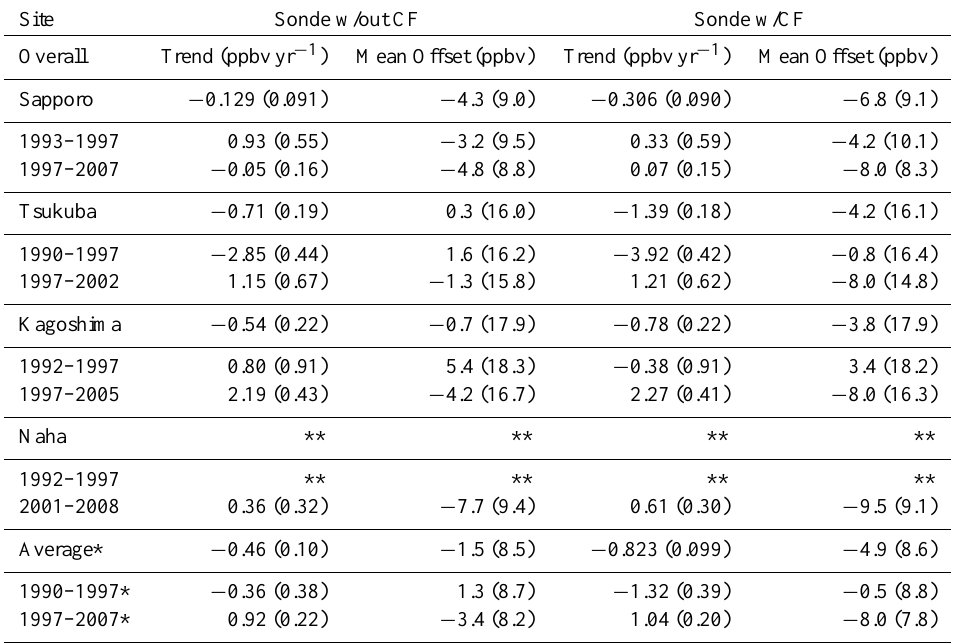
Table 7. Trends in the differences between sonde and surface measurements, and the mean offsets in those differences (Japanese ozonesonde average from the surface to 100m above the surface minus surface monitor hourly ozone average) for the period 1990–2007 as computed with and without the CF applied. The average means and offsets are computed using a Monte Carlo